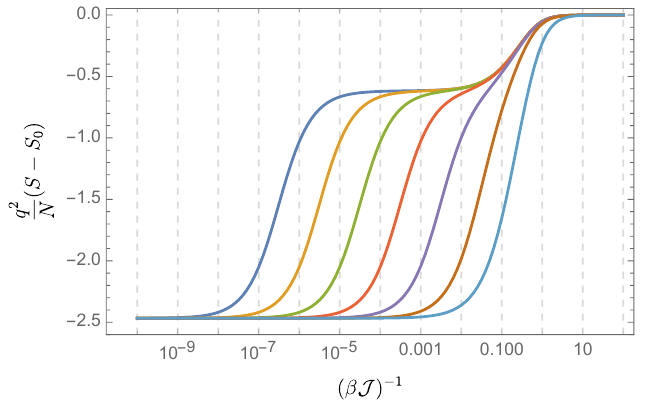
Figure 1 . Entropy as a function of the temperature (in logarithmic scale) to leading or- der in the large N and q expansion. Different curves correspond to different values of s 2 = 10 − 6 , 10 − 5 , 10 − 4 , 10 − 3 , 10 − 2 , 10 − 1 , 10 0 , from left to